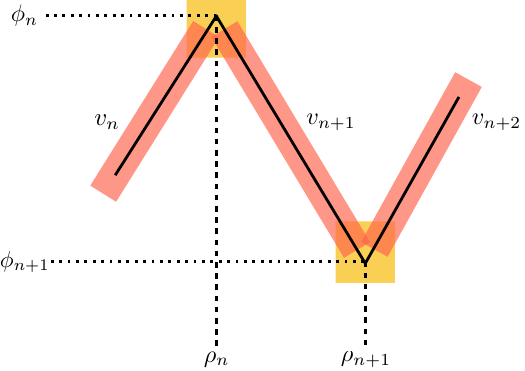
Figure 5: Overlap of the Kasner (red rectangles) and extended bounce (orange squares) regimes. The n th bounce is strongly localized to ρ ≈ ρ However, the extended bounces described by (24) are wider and overlap with the Kasner regimes. On the n th Kasner regime ˙ φ ≈ v